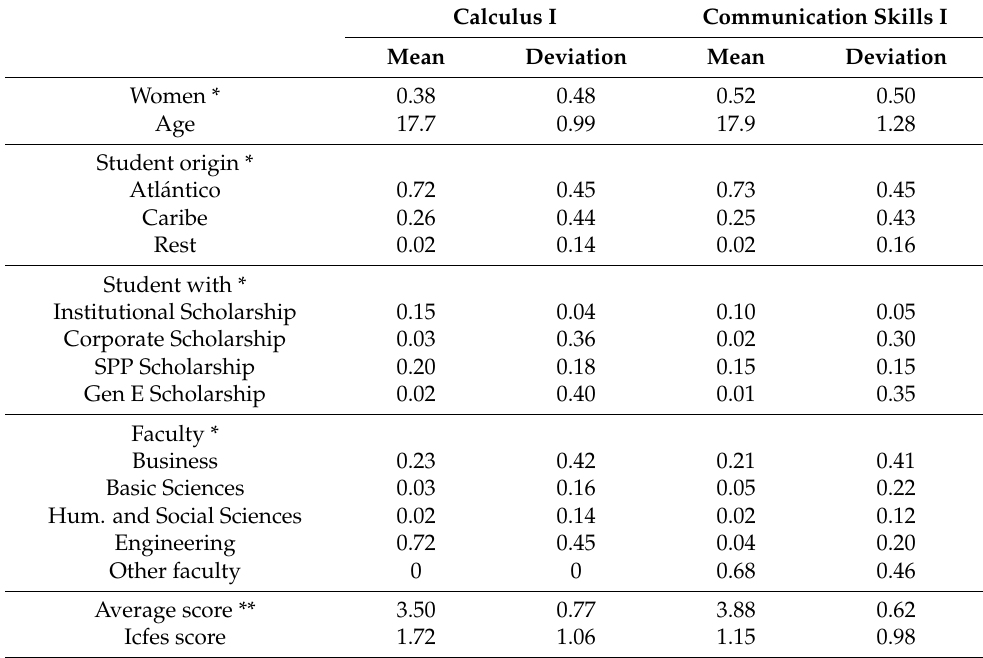
Table 1. Descriptive